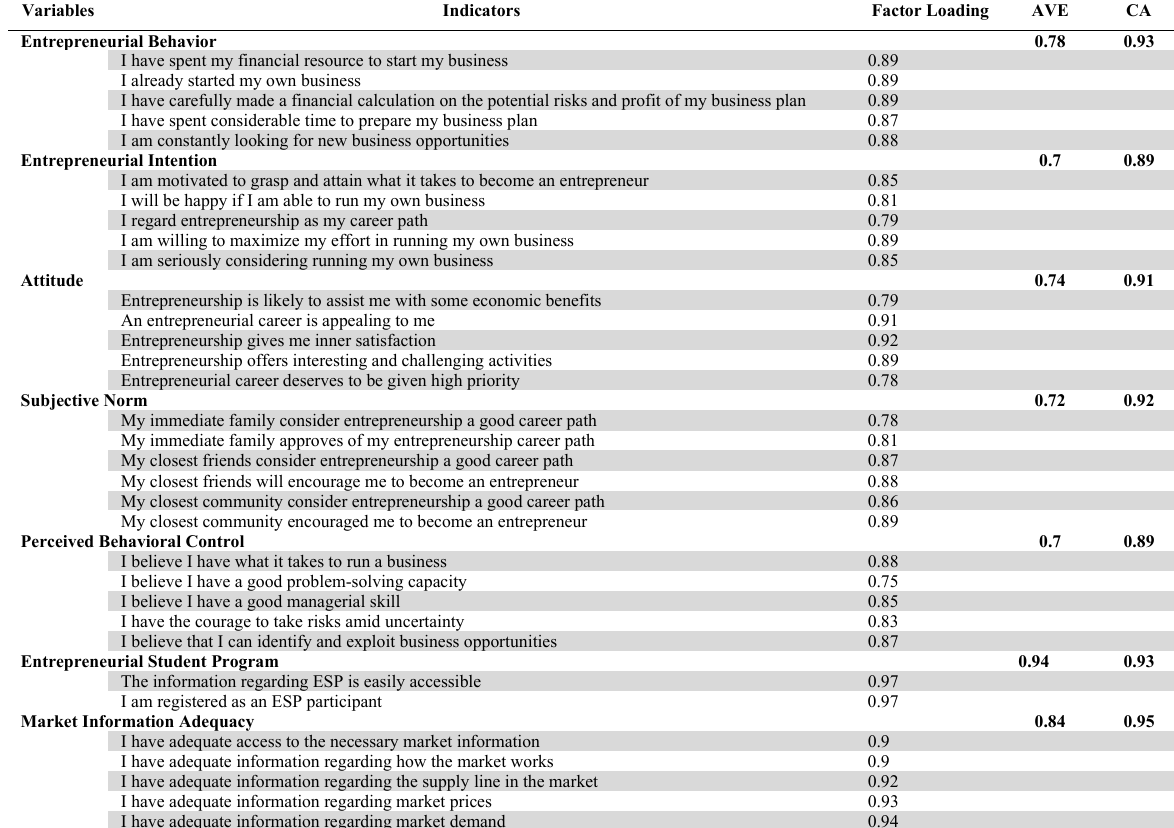
The Results of Composite Reliability and Convergent Validity Tests